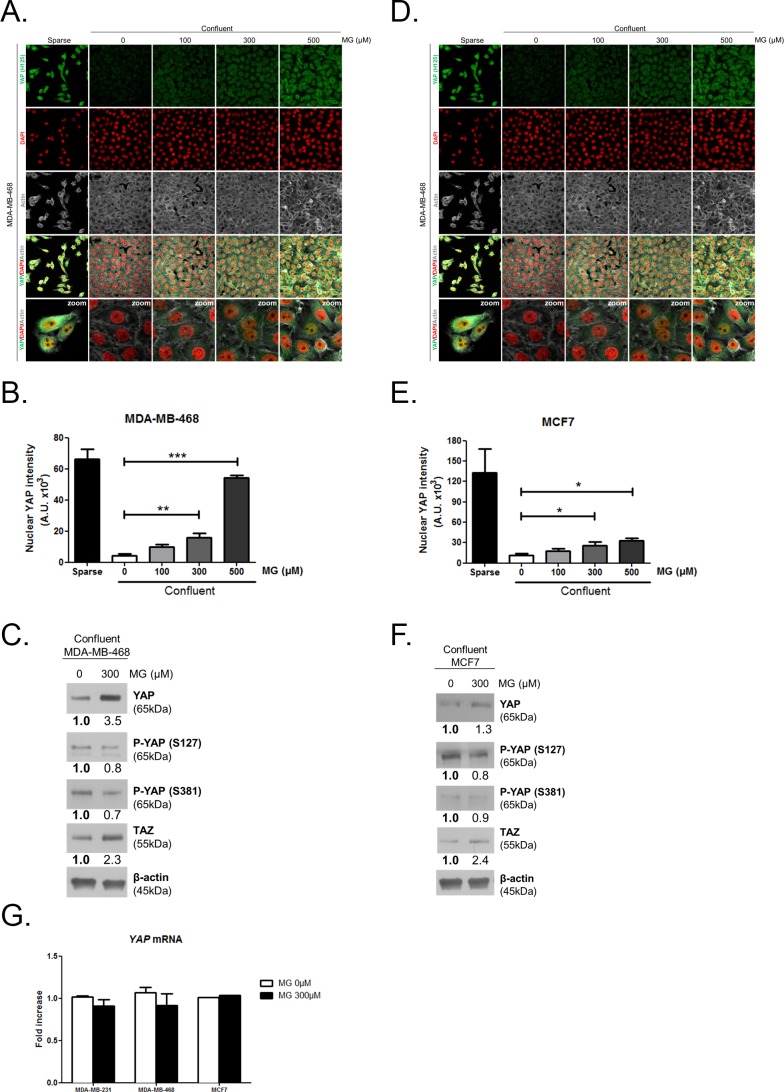
Methylglyoxal induces YAP accumulation in confluent breast cancer cells.(A and D) Immunofluorescence staining shows that YAP (Santa Cruz antibody, H125) is mainly localized in the nucleus at low cellular density (Sparse) and is weakly detectable at high cellular density (Confluent) in MDA-MB-468 and MCF7 cells. In contrast, cells treated with increasing doses of MG until they reach confluence showed YAP cellular accumulation. Magnification 630x. Zoomed pictures are shown where indicated. Data are representative of three independent experiments. (B and E) Quantification of panel A and C experiments reports the intensity of YAP staining that colocalized with DAPI staining as described in 'Materials and methods' section. Nuclear YAP IF staining intensity shows a significant dose-dependent increase in presence of MG. Data were analyzed using one-way ANOVA followed by Dunnett post-test and shown as the mean values ± SEM of three independent experiments. (C and F) YAP, P-YAP (S127 and S381) and TAZ expression in MDA-MB-468 and MCF7 cells treated with MG (300 µM) until they reach confluence using western blot. Immunoblot data were quantified by densotimetric analysis and normalized for β-actin. Data are representative of three independent experiments. (G) qRT-PCR analysis of YAP gene in the indicated breast cancer cells treated with MG. Data were analyzed using unpaired student’s t test for each cell line and shown as the mean values ± SEM of three independent experiments. *p<0.05, **p<0.01 and ***p<0.001.